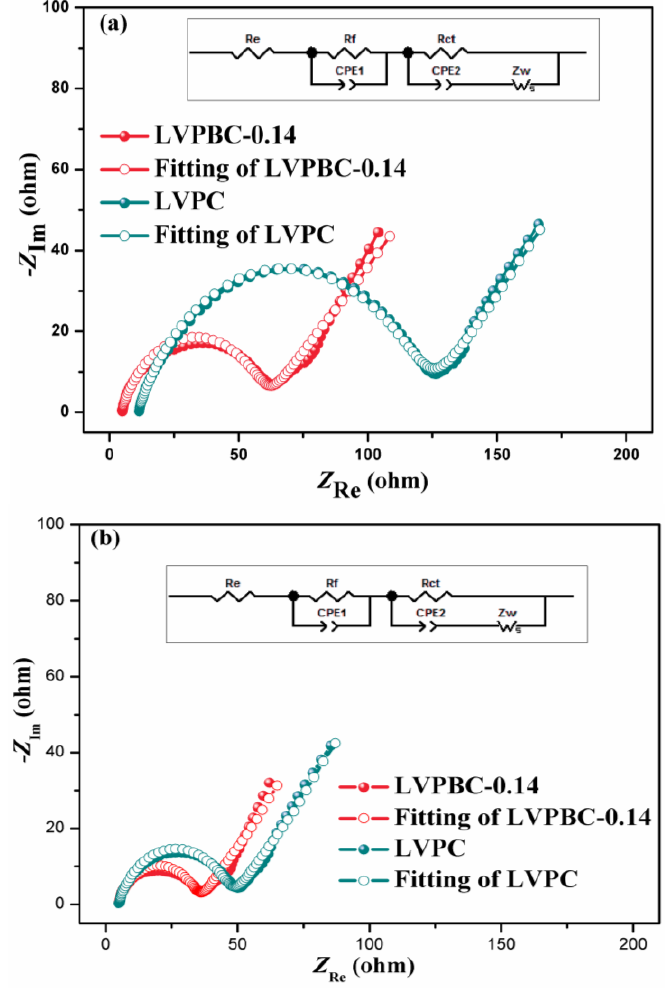
Figure 7. Electrochemical impedance spectroscopy (EIS) of the LVPBC and pristine LVPC composites under fully discharged state at the 10th ( a ) and 20th ( b ) cycles. Table 2. R ct fitting values of the LVPBC-0.14 and pristine LVPC composites at different cycles.